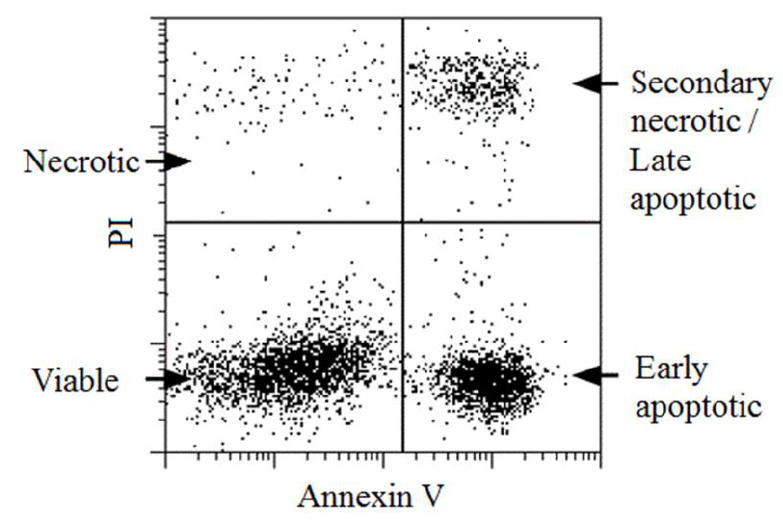
Figure 4. Schematic figure of annexin V positivity of sperm cells. Dead cells can be labelled basically with propidium iodide, but in some cases, these cells are also positive for annexin V.